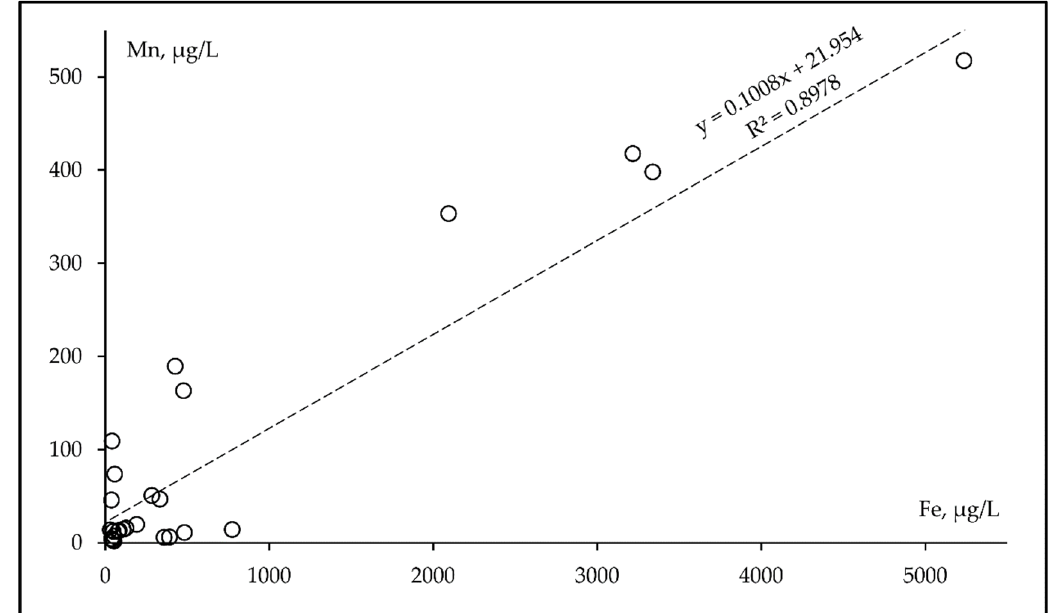
Figure 3. Correlation between Fe concentration and Mn content in the studied lakes. Comparison of the concentrations of trace elements in the Murmansk lakes with their concentrations in the lakes of the border zones of Russia, Finland, and Norway (Table 3) showed that the concentration of Cu in the Murmansk lakes was on the same level as Norway. Moreover, Ni concentrations in the Murmansk lakes were 1.8 times higher than in Norway. The highest concentrations of these elements are common for the north-western part of Murmansk region. As noted above, Cu and Ni are some of the most common pollutants from non-ferrous metallurgical plants, located in this area. The highest concentrations were found in lakes located close to metallurgical plants: Lake Haukilampi (Cu— 8.3 μ g/L; Ni—109 μ g/L), LN-2 (Cu—9.8 μ g/L; Ni—265 μ g/L), LN-3 (Cu—13.6 μ g/L; Ni— 111 μ g/L), Lake Kuetsjarvi (Cu—8.6 μ g/L; Ni—106 μ g/L) [41]. The lowest concentrations of Cu, Ni, and Pb were observed in the lakes of Finland. The mean Pb content in other regions was similar and varied from 0.23 to 0.28 μ g/L. In turn, the lakes of Murmansk and Finland were characterized by high concentrations of the mean Fe content, which is com- mon for small lakes in these regions. Meanwhile, the highest concentrations of Fe were observed in the Murmansk lakes and they were 1.9 times higher than in the Finnish lakes. Table 3. The mean contents of microelements in the Murmansk lakes and the neighboring zones of Russia, Norway, and Finland, μ g/L [41]. Cu